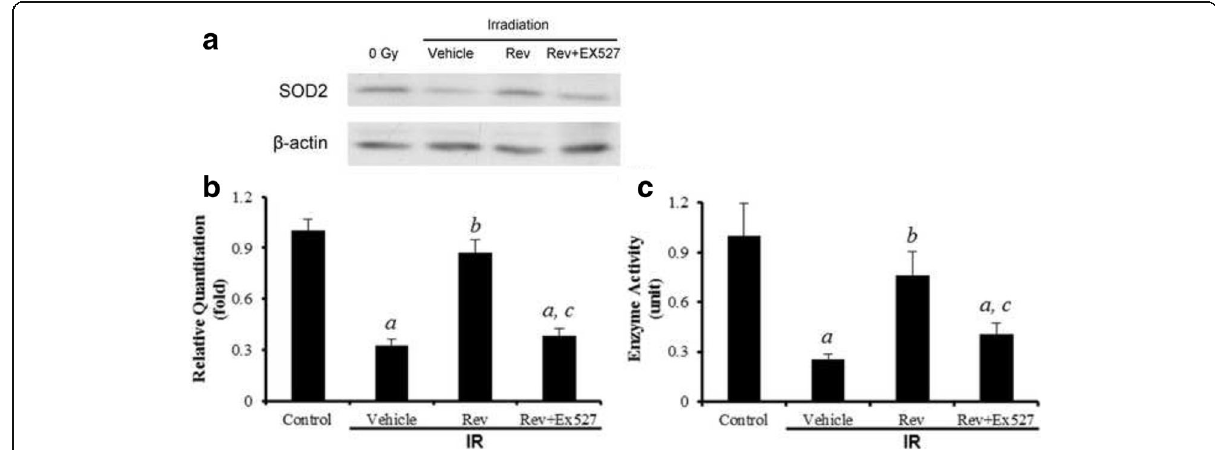
Fig. 4 Resveratrol ameliorate IR-Induced reductions in SOD2 expression and activity. a The levels of SOD2 expression; ( b ) Quantitative analysis of the SOD2 expression; ( c ) Quantitative analysis of the enzyme activity of SOD2. The data are presented as means ± SE. n = 6 mice per group. a p < 0.01 vs control; b p < 0.05 vs IR; c p < 0.05 vs IR +